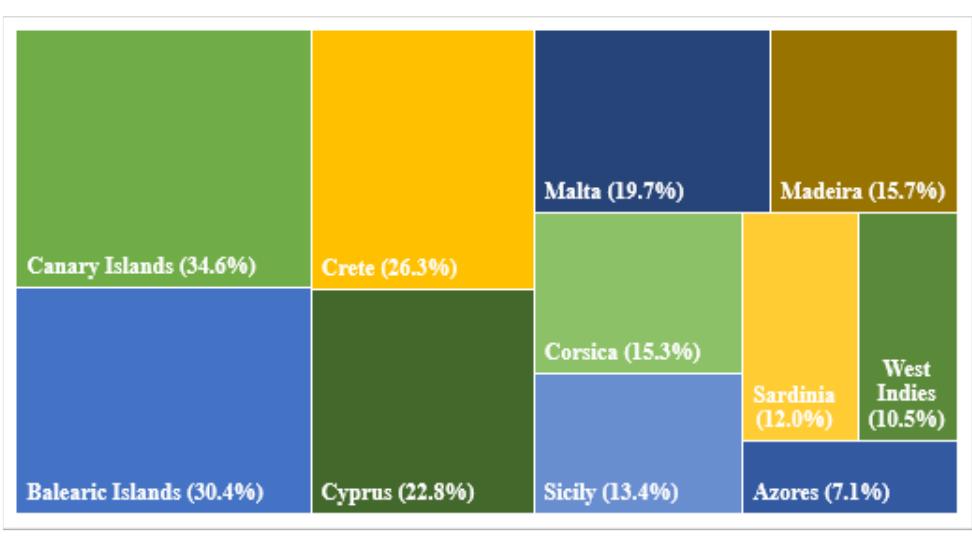
Figure 2. Percentage of previous visits to the EU islands of